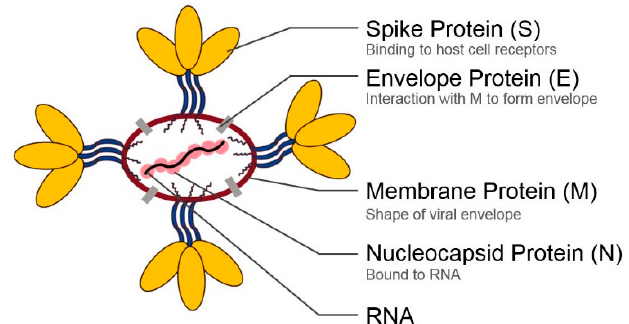
Figure 1. Basic structure of SARS-CoV-2 including its genome RNA and the four main structural proteins. The schematic is not drawn to scale. Enlargement has been employed to better depict the structures.